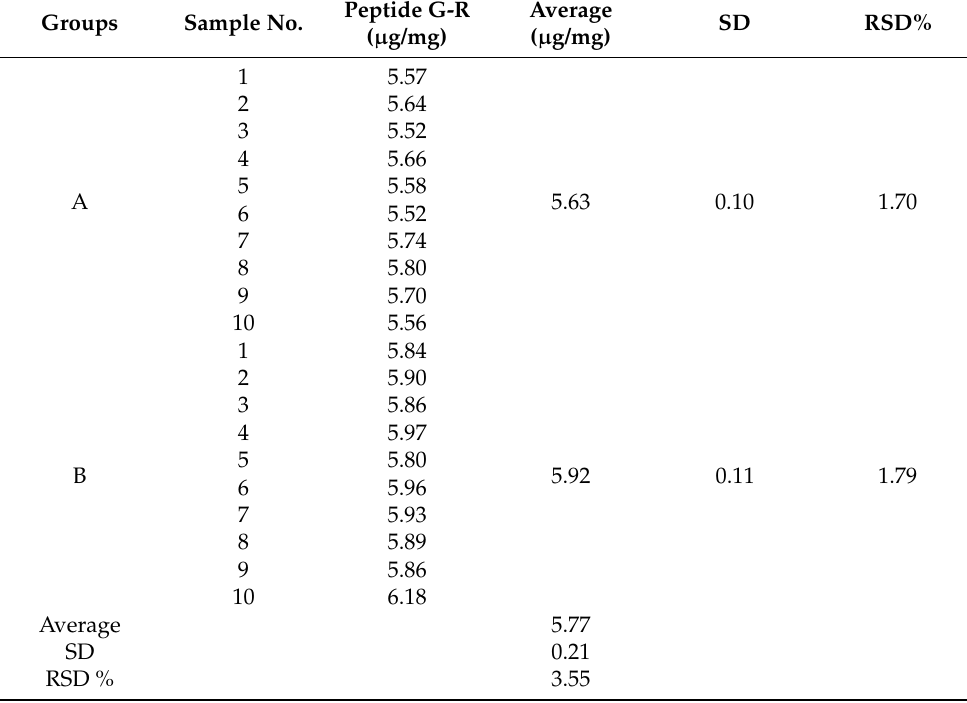
Table 2. Precision of quantification method for peptide G-R of bovine type I collagen. Groups